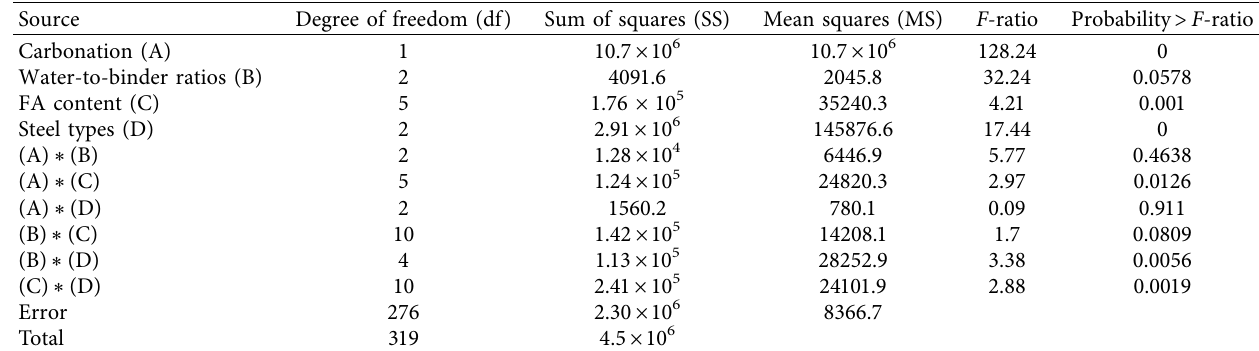
Table 8: ANOVA result for rest potential of carbonated